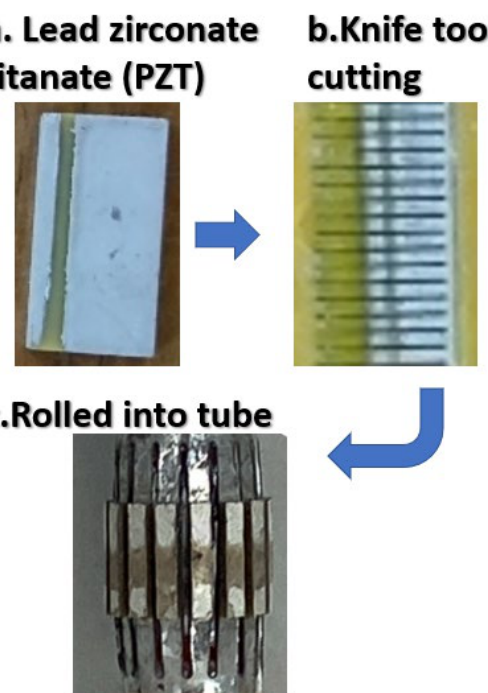
Figure 6. Fabrication steps. ( a ) Lead zirconate titanate (PZT); ( b ) Knife tool cutting; ( c ) Rolled into tube.